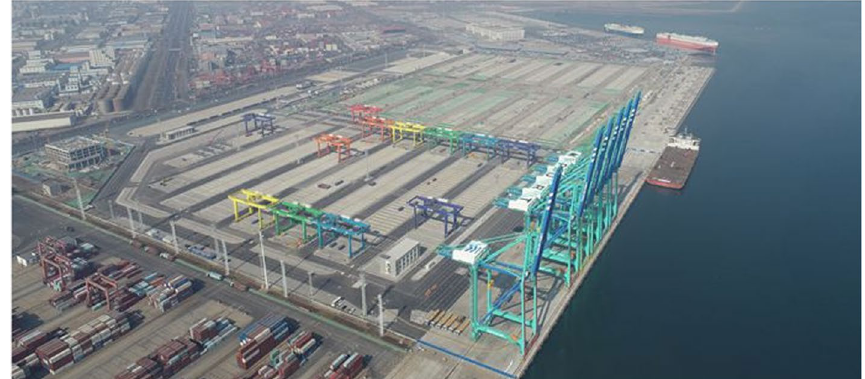
Fig. 6 Tianjin port (source: Wikimedia Commons, the image belongs to the public